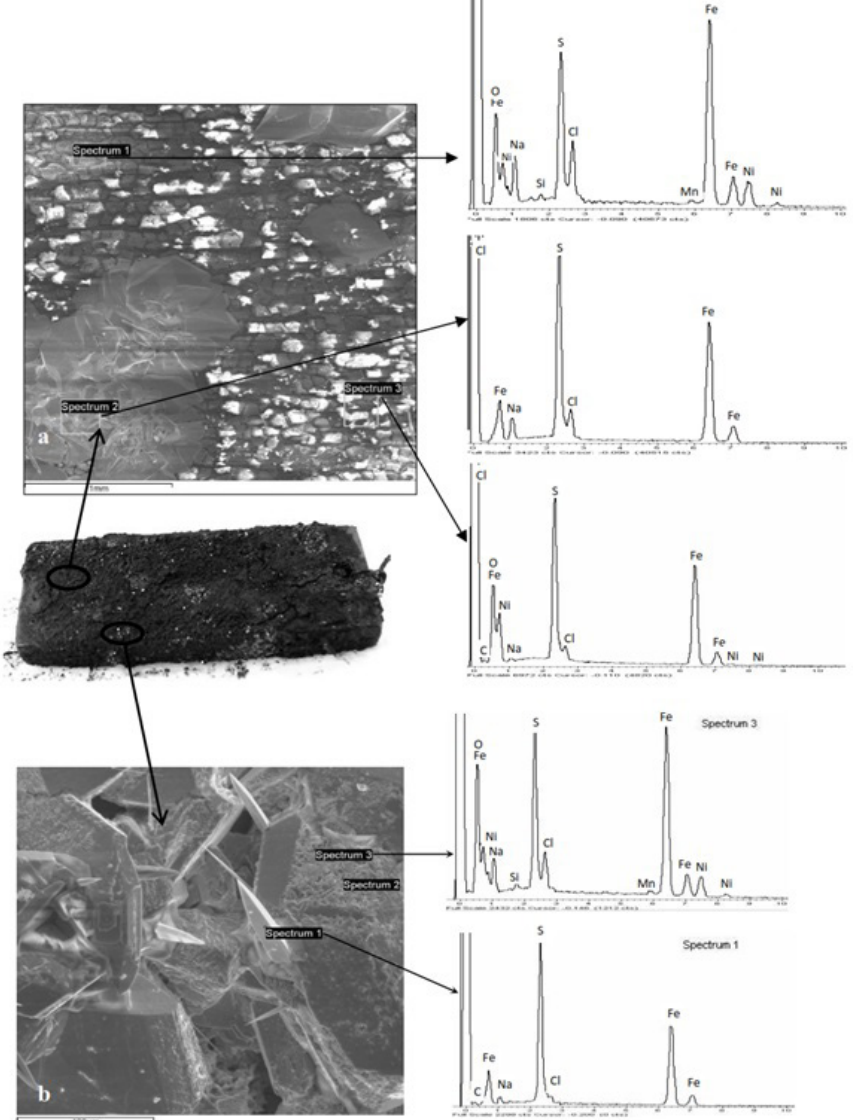
Figure 9. SEM and EDS characterization of the corrosion product film on the surface of the welded joint that was tested in solution 2 with